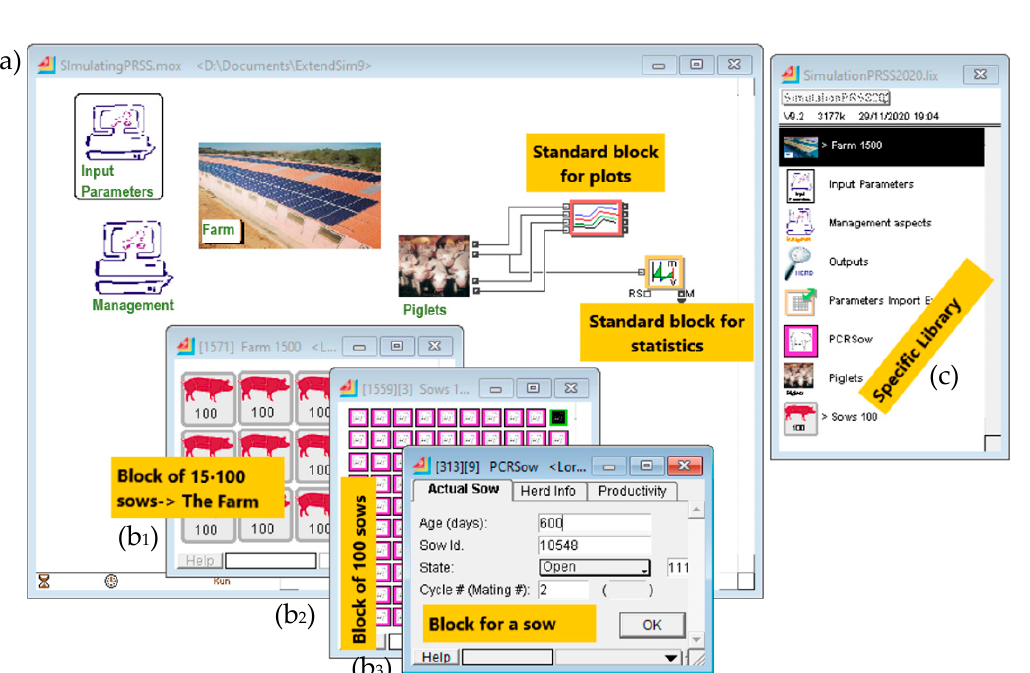
Figure 1. Digraph representing the (first) reproductive cycle of a sow: the states (the eight num- bered nodes) and transitions allowed are represented by arrows. Note that there is an entry state representing the purchase of gilts and a link to the next reproductive cycle state (gray color).